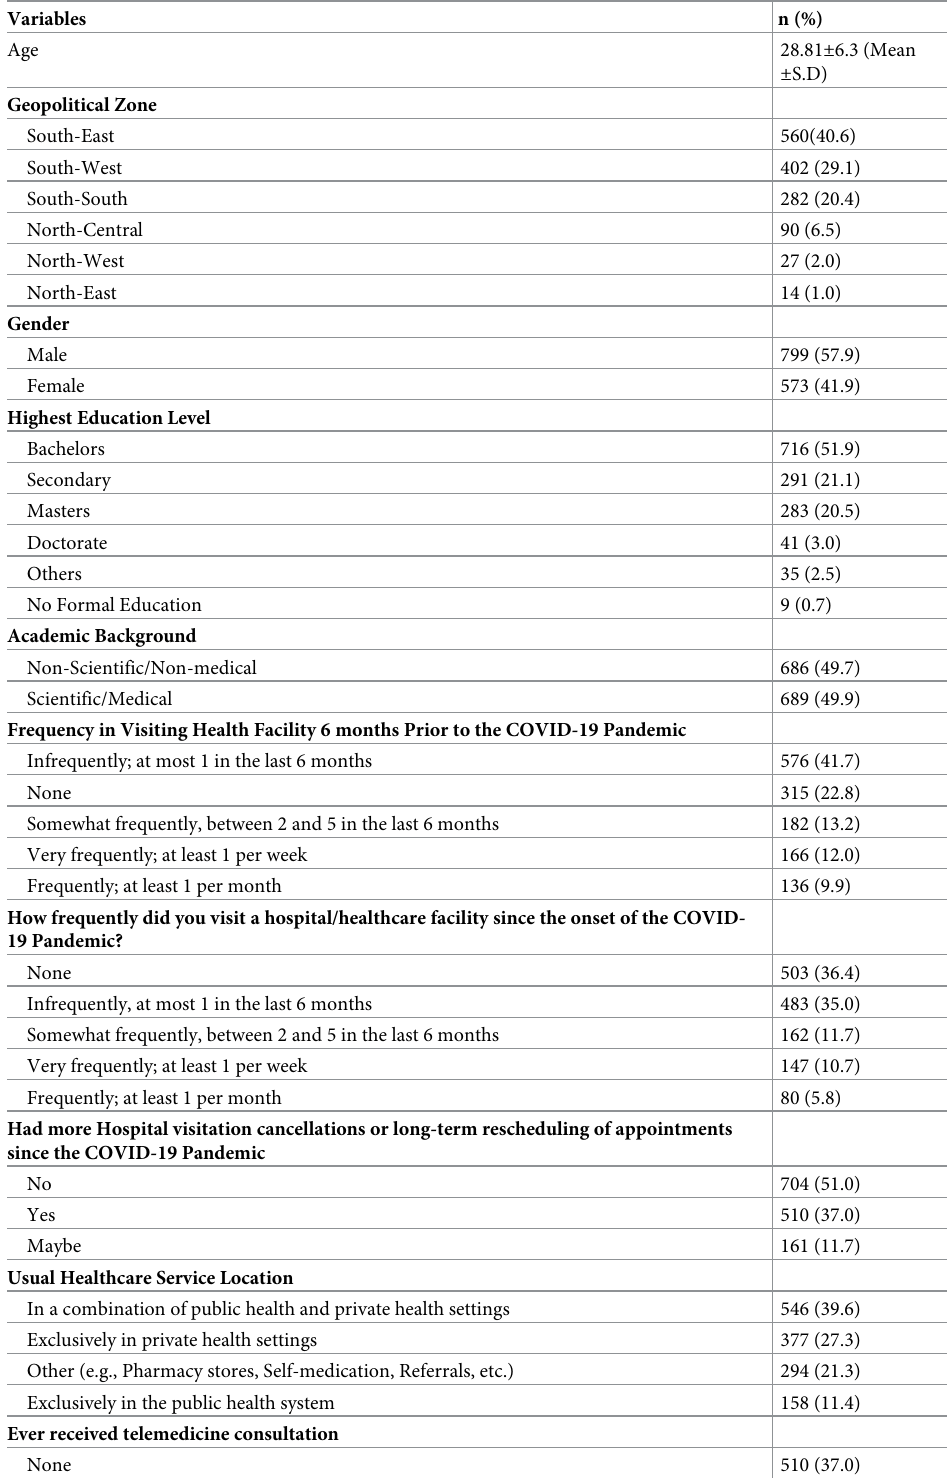
Table 2. Healthcare consumers characteristics (N =